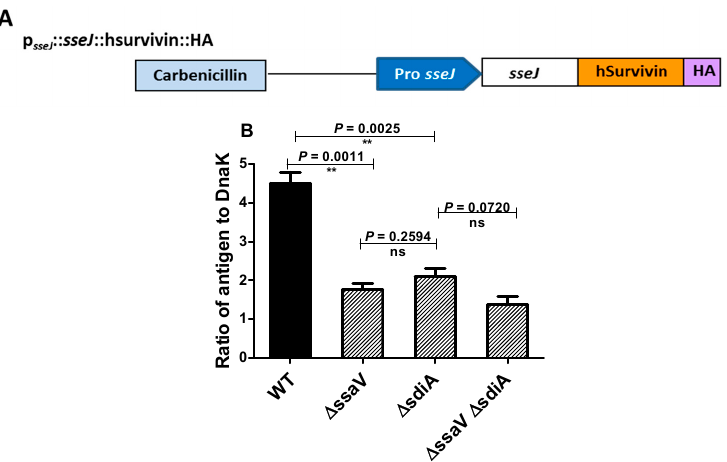
Figure 6. Expression of SPI2 effectors. ( A ) Plasmid-encoding SPI2 effector tagged with HA was constructed in order to test the efficacy of SPI2-TTSS-dependent translocation. ( B ) Expression of translocated proteins was evaluated as ratios of the HA to DnaK signals (**= p < 0.01)